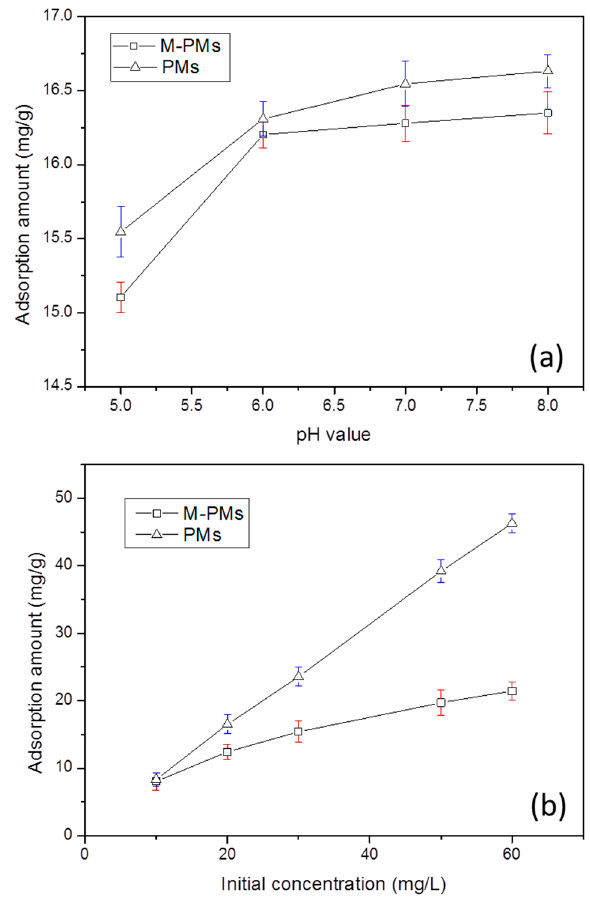
Figure 5. Study of the impacts of pH ( a ) and initial MG concentration ( b ) conditions on the adsorption amount of MG using M-PMs and PMs as adsorbents; the error bars indicate the standard deviation of three independent measurements. The test conditions for ( a ): at 35 °C, initial MG concentration = 20 mg/L, dosage of microspheres = 0.03 g, and volume of the MG solution = 25 mL. The test conditions for ( b ): at 35 °C, pH 7, dosage of microspheres = 0.03 g, and volume of the MG solution = 25 mL.